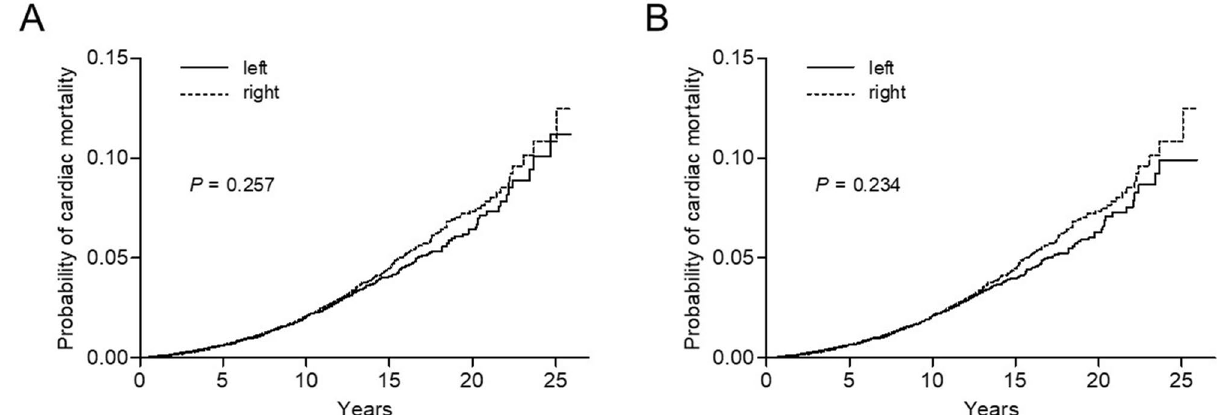
Figure 1. Cumulative incidence of heart-related mortality in the study population overall: ( A ) before and ( B ) after propensity score matching.